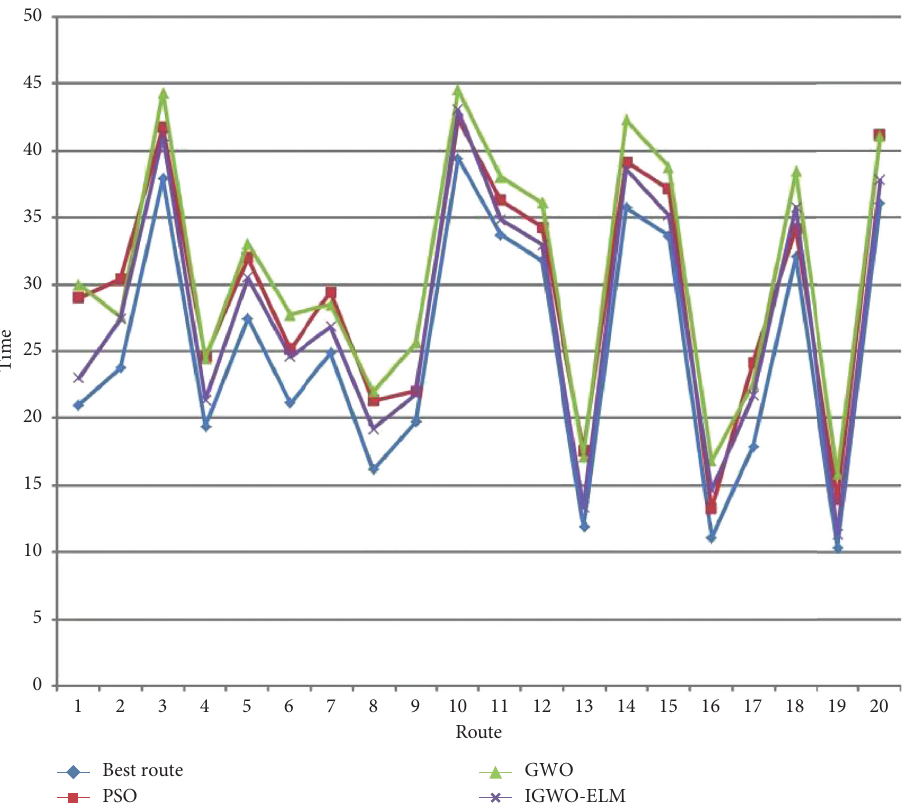
Figure 3: Comparisons of three algorithms under different